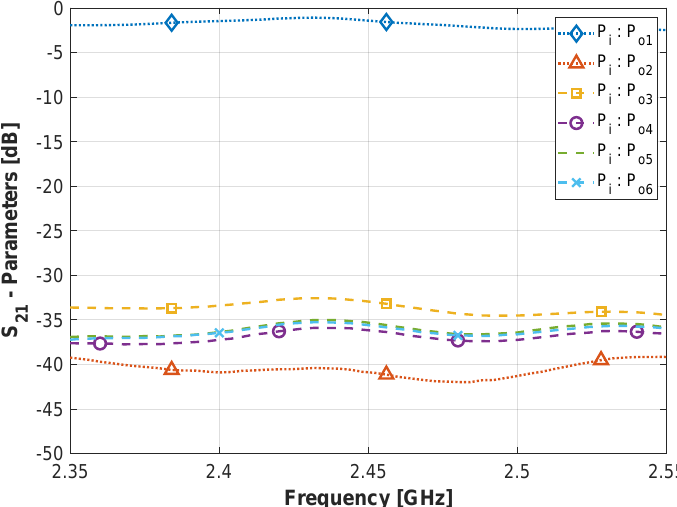
Figure 6. Measured isolation and insertion loss of the RF switch (plus cables).